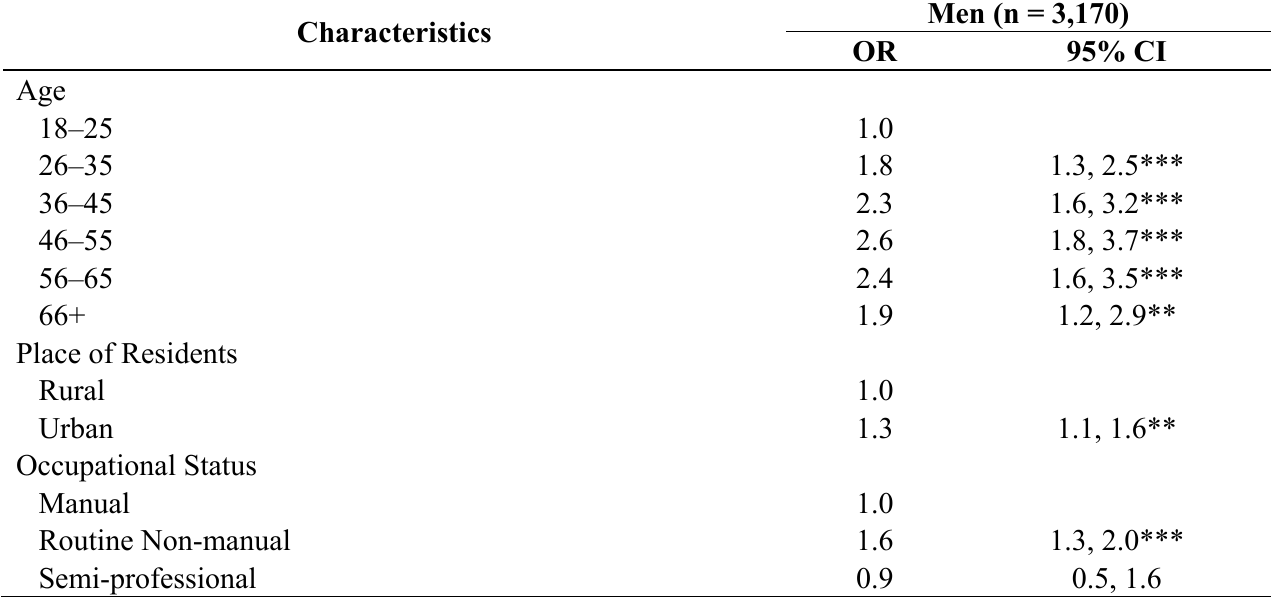
Table 3. Logistic Regression Models on the Likelihood of Being Overweight (Odd Ratios (OR) and their 95% Confidence Intervals (CI) in